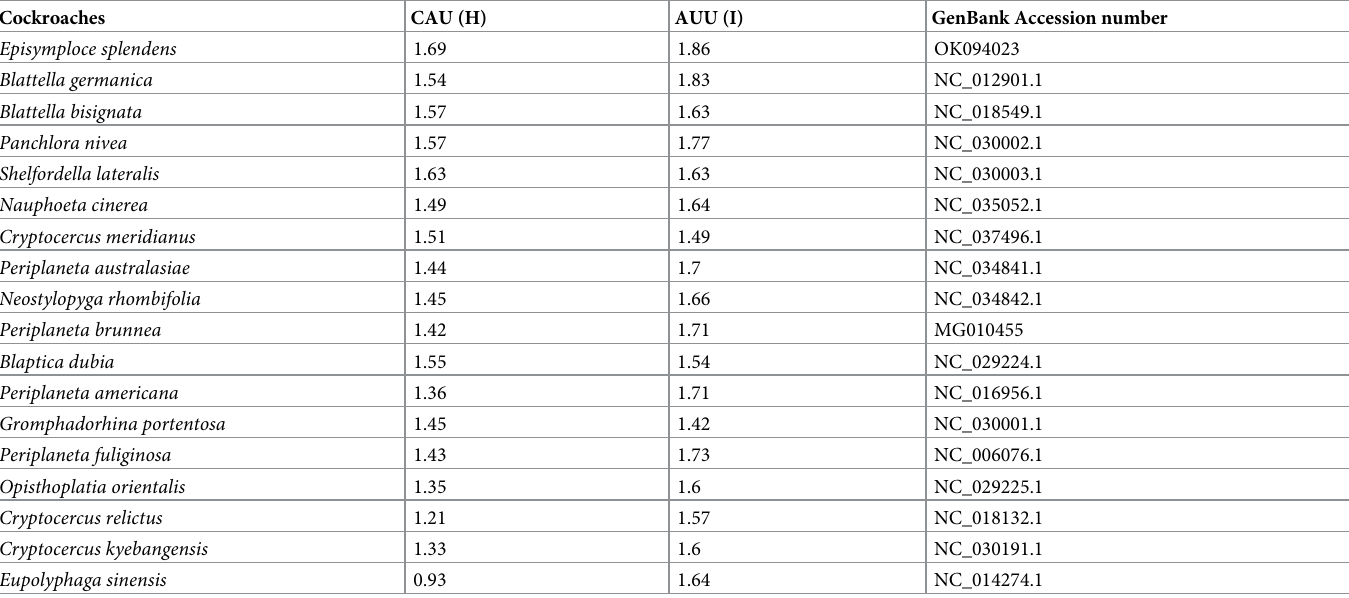
Table 4. The RSCU values of CAU (H) and AUU (I) in known cockroaches.